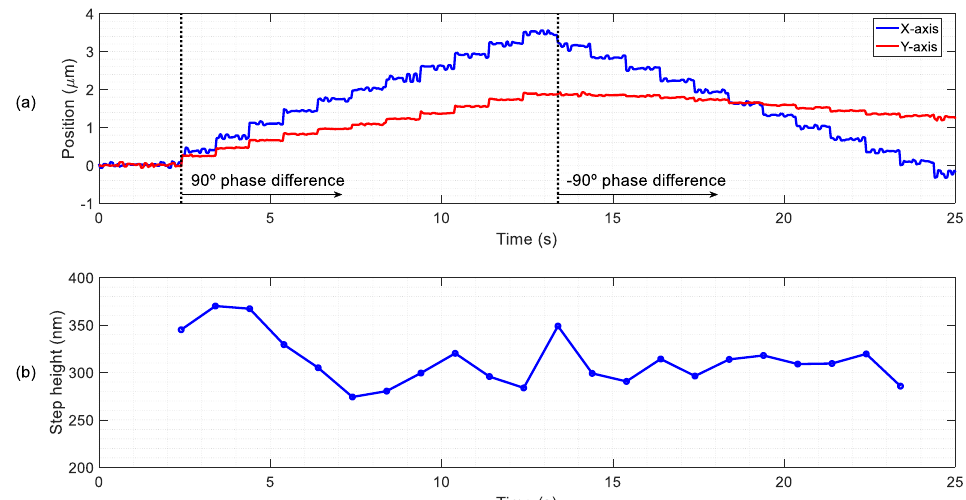
Figure 10. Study of the minimum displacement of the slider for 10 sinusoidal cycles of 10 V at 19 kHz. ( a ) Discrete steps on the direction of propagation of the TW ( X -axis) and the orthogonal one ( Y -axis) and ( b ) estimated step height.